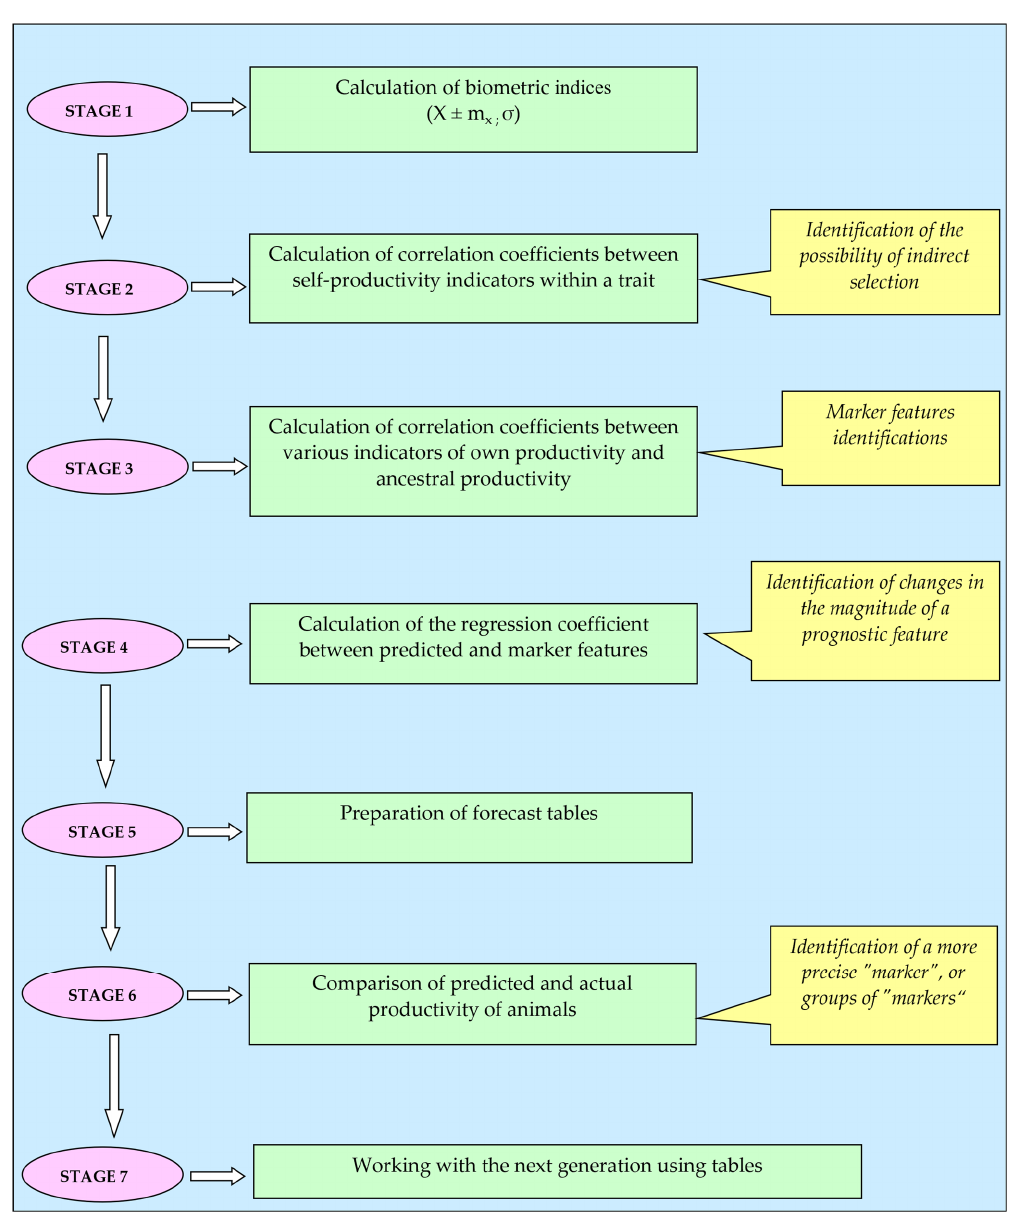
Figure 1. Productivity prediction algorithm.